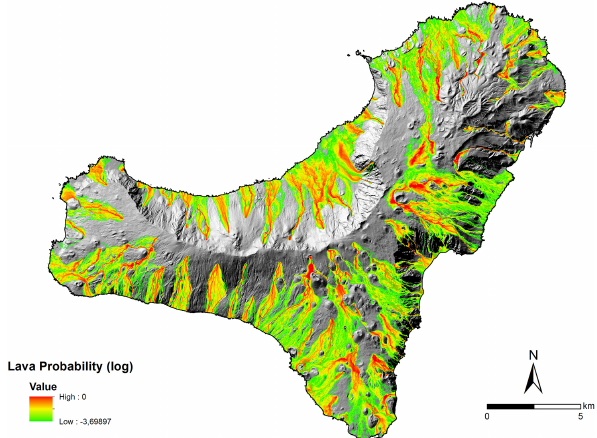
Figure 4. Lava flow scenarios for El Hierro performed with VORIS 2.0.1. Vents from lava flows that have been simulated rep- resent those with the highest spatial probabilities (see susceptibility map in Fig. 2). Red colours are those areas with the highest proba- bility to be invaded by lava